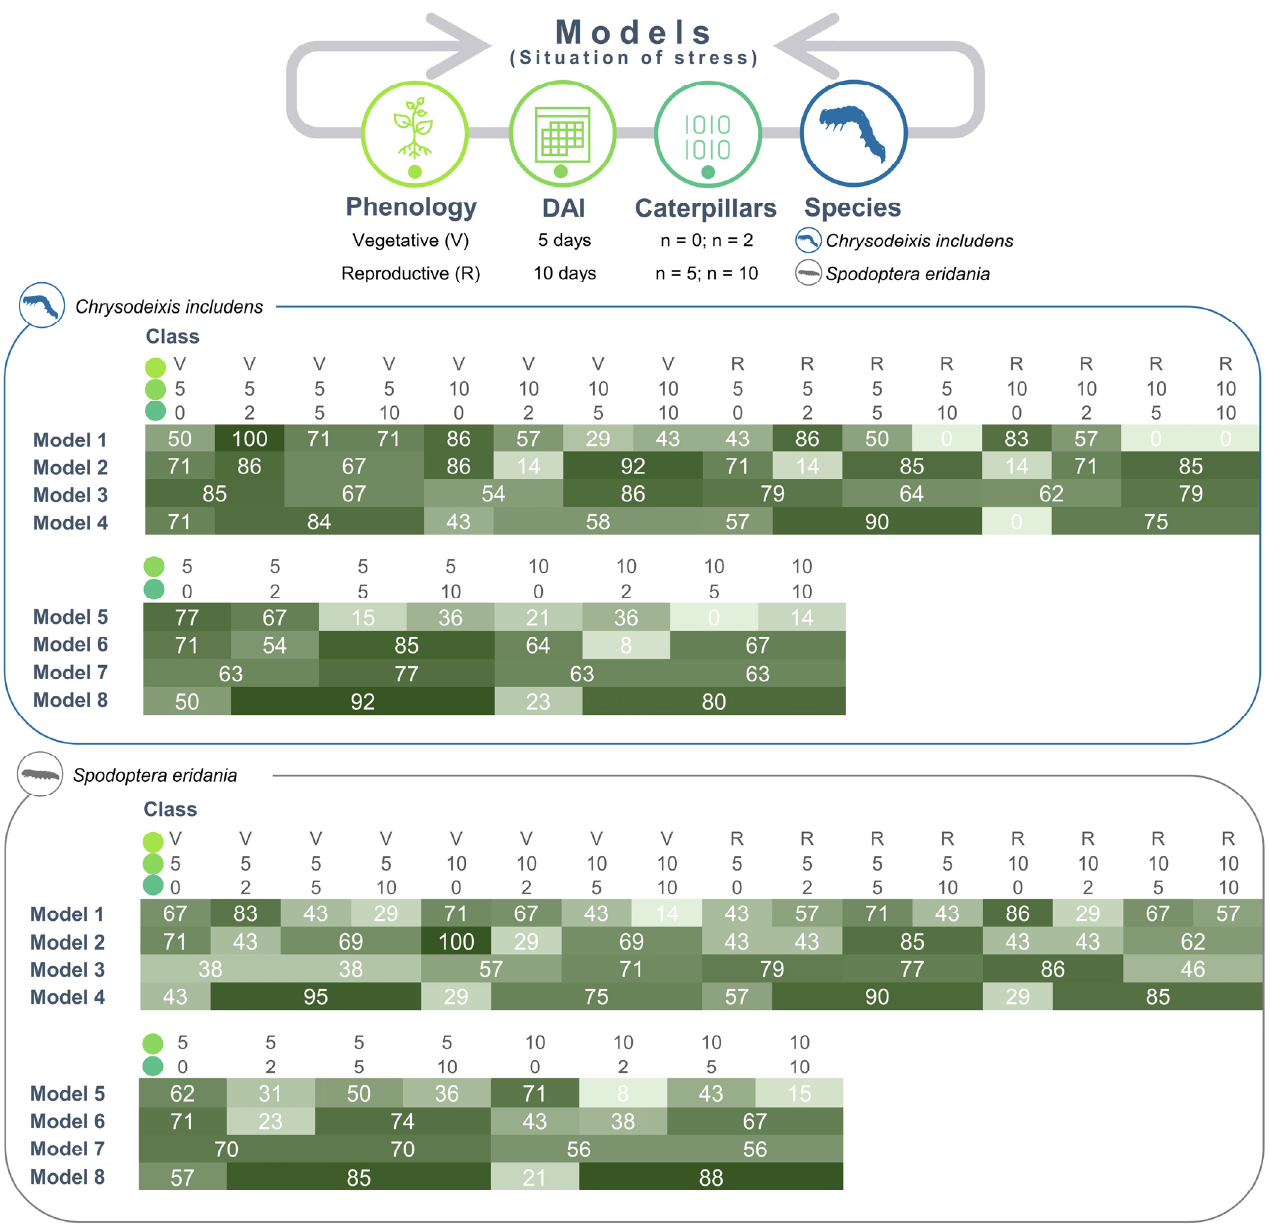
Figure 5. Prediction from the confusion matrices for the classification of soybean plants under different situations of stress caused by Chrysodeixis includens (Group 2) and Spodoptera eridania (Group 3) based on a multilayer perceptron artificial neural network classifier. Situation of stress = Phenology + Days after infestation (DAI) + Caterpillars (n): Phenology = Soybean Vegetative (V) and Reproductive (R) stages, Days after caterpillar infestations (DAI) = 5; 10, Density (n) of caterpillars per cage with five plants (0, 2, 5, and 10).